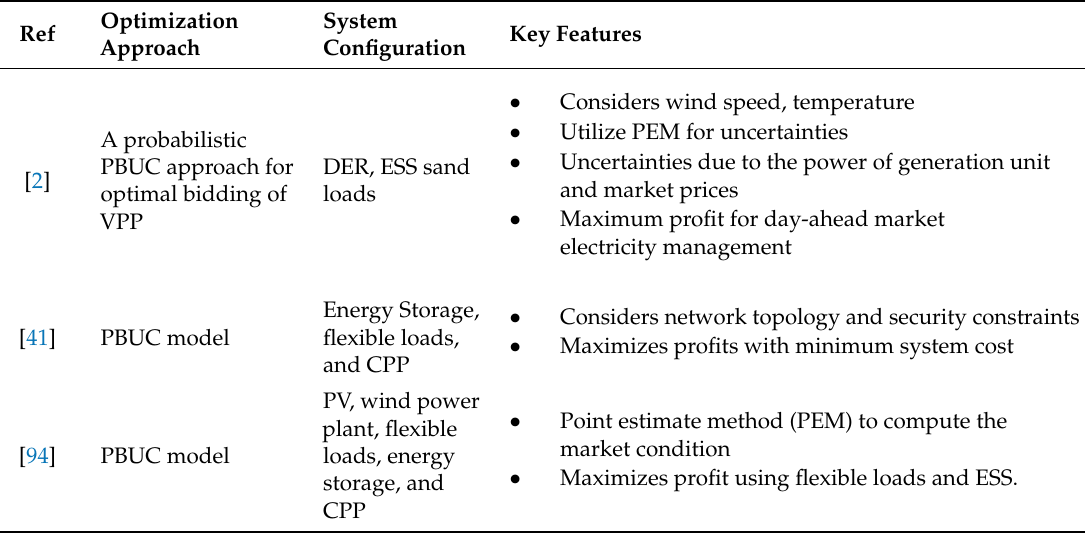
Table 4. A comparative analysis among di ff erent priced-based unit commitment models for virtual power